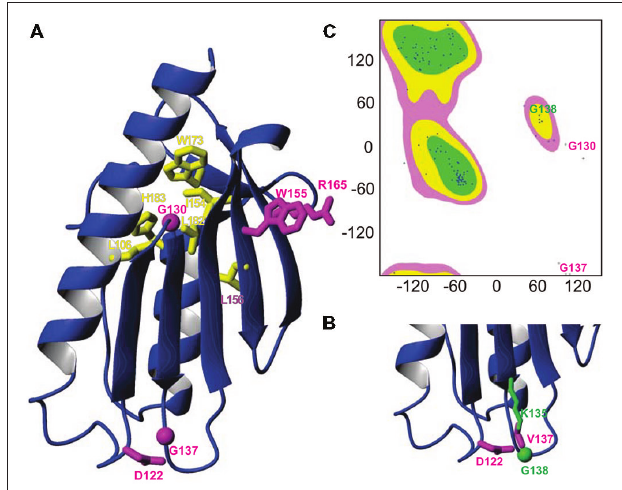
FIGURE 1 | Mapping the G137V mutation on the frataxin structure. (A) Ribbon diagram of the human frataxin C-terminal domain (residues 92–210, pdb code 1LY7). The side chains of clinically important mutations are shown explicitly (glycines are identified by spheres). Buried residues which participate to the hydrophobic core are shown in yellow, exposed residues are shown in magenta. (B) Zoom on the loop hosting G137 in silico mutated to valine with the surrounding residues N122 and L135, highlighting a possible steric hindrance caused by the mutation. (C) Ramachandran plot of the frataxin where glycines 130 and 137 are explicitly